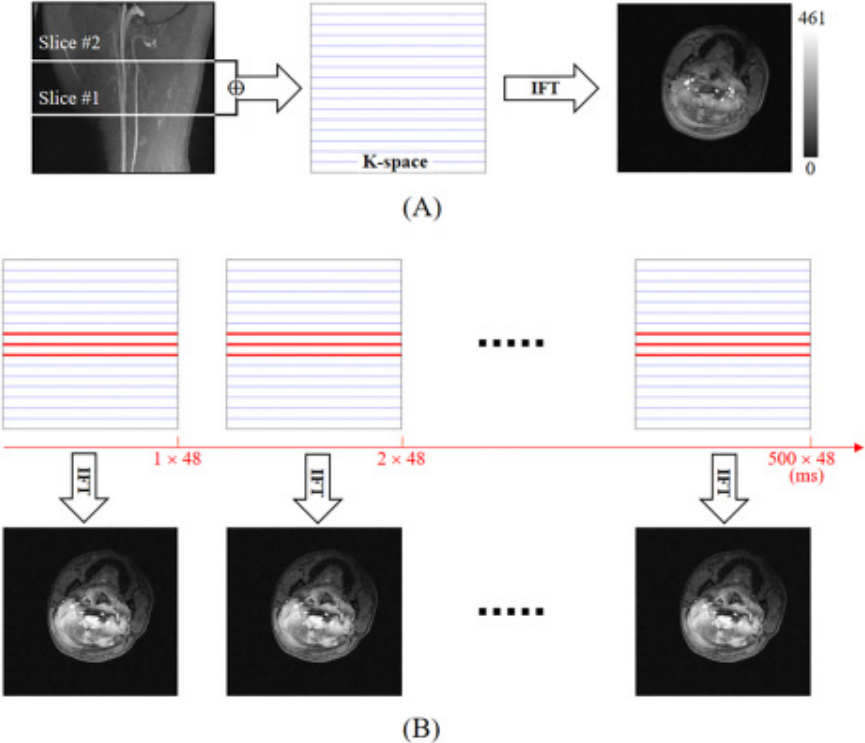
Figure 1. Conceptual diagram of SMS-K technique. ( A ) The reference SMS-K image with full K-space acquisition lines containing all information from both slices (3rd and 9th). ( B ) The 500 SMS-K measurements using keyhole acquisition and reconstruction technique. Because one measurement acquires three K-space center lines (red thick lines), a scan time of 48 ms is required. Note that repetition time (TR) is 16 ms. Other K-space information from the reference SMS-K data was used for the keyhole reconstruction (blue thin lines). A gray scale bar indicates the signal intensity. Abbreviations: SMS-K, simultaneous multi-slice keyhole technique; IFT, inverse Fourier transform.